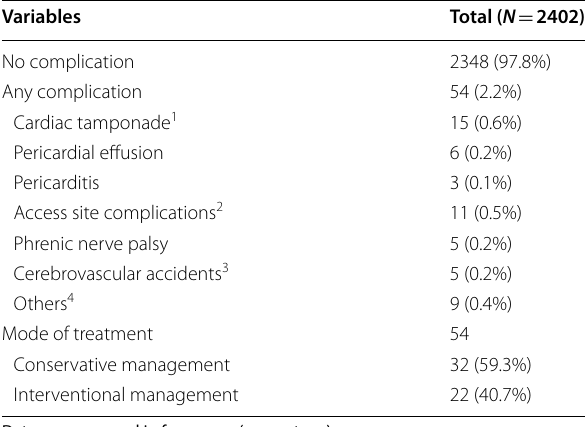
Table 4 Acute post‑procedural